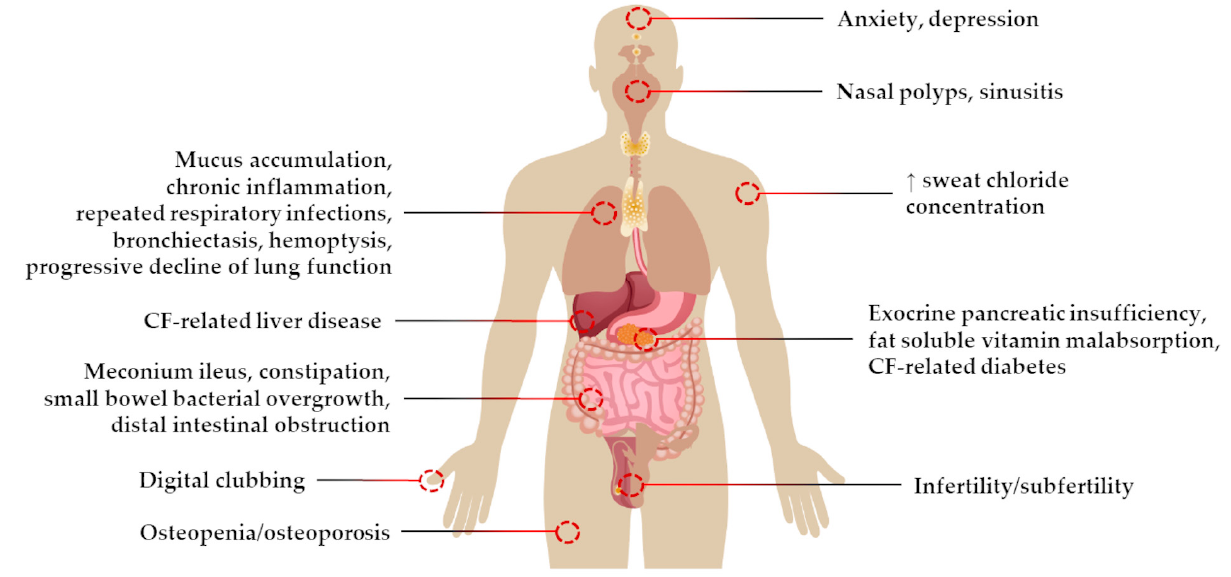
Figure 1. Major clinical manifestations developed by people with cystic fibrosis. The deletion of a phenylalanine at position 508 (F508del) is by far the most prevalent CF-causing mutation, occurring in 80–85% of CF cases worldwide [2]; however, more than 2100 CFTR genetic variants have been reported to date (http://www.genet.sickkids.on.ca/, accessed on 22 December 2022), most being presumably pathogenic and leading to a broad range of phenotypes, from classical CF to mild disease symptoms (https://cftr2.org/, accessed on 22 December 2022). Therefore, CFTR mutations have been grouped into six functional classes according to the primary CFTR defect, characterized by: (I) no production of the full-length protein, (II) impaired protein folding and trafficking, (III) defective channel gating, (IV) reduced channel conductance, (V) reduced protein production, and (VI) reduced protein stability at the plasma membrane [2,9,10]. Since people with CF (PwCF) may carry different CFTR mutations on the two alleles, thousands of possible combinations of CF genotypes exist (https://cftr2.org/, accessed on 22 December 2022). Up to 2012, CF therapies were focused on the management of disease signs, symp- toms, and complications. These include inhaled and physical therapies and various daily medications, including conventional mucolytics, antibiotics, anti-inflammatory agents, and pancreatic enzymes, and monitoring by a multidisciplinary healthcare team (physi- cians, nurse, nutritionist, physiotherapist, and psychologist) [1,3,11]. With the advances in fundamental and translational research by developing preclinical cell models and by implementing cell-based high-throughput screening assays, novel therapies that directly target the primary CFTR defect(s) were discovered [10,12]. These are CFTR modulator drugs that can restore the folding and trafficking of mutant CFTR protein (correctors) or en- hance the channel open probability (potentiators) when the protein is located at the plasma membrane [2,11]. To date, four CFTR modulators drugs have been approved for clinical use by both the Food and Drug Administration (FDA) and the European Medicines